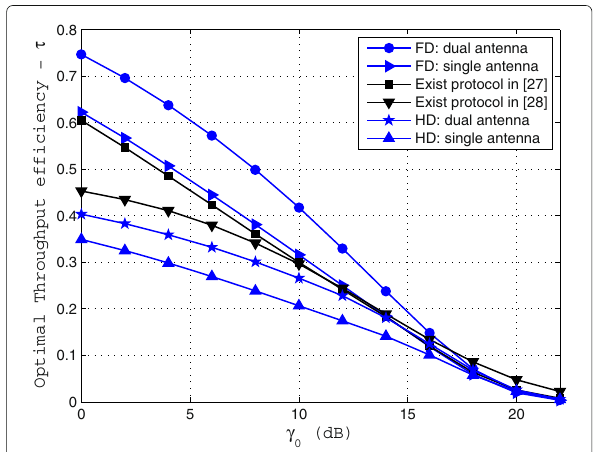
Fig. 8 Throughput efficiency versus γ 0 and the comparison with existing protocols in [27, 28] with λ f = − 20 dB and m f = 1